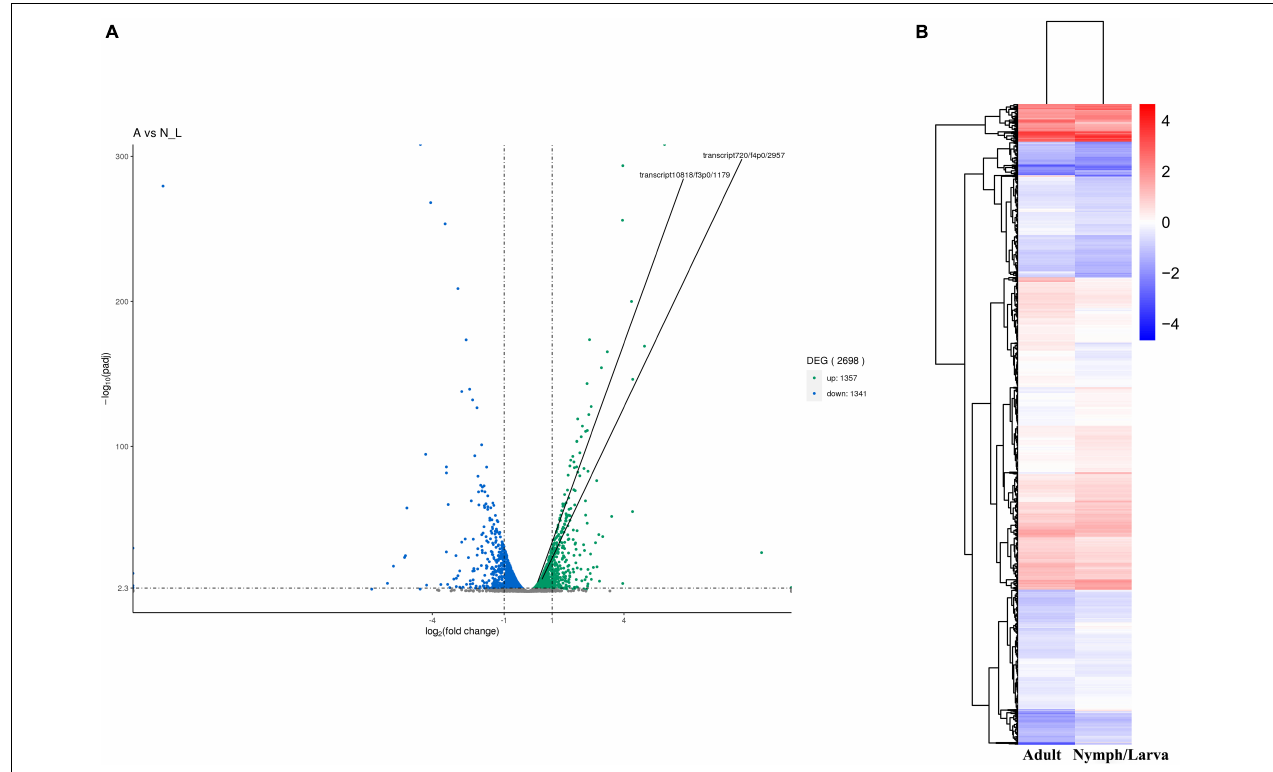
FIGURE 4 | (A) Map of the number of differentially expressed genes. (B) Cluster map of DEGs.